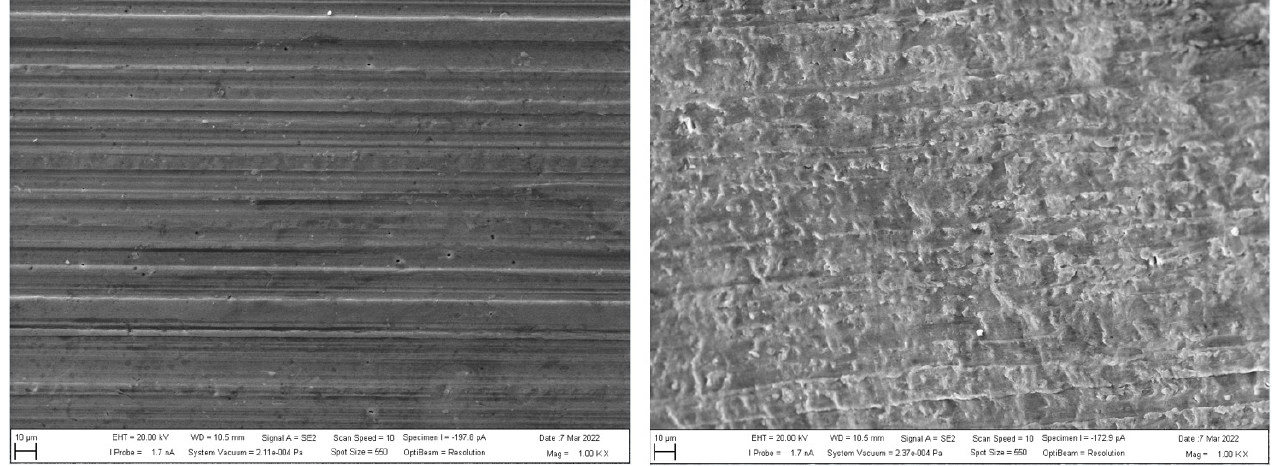
Figure 12. Comparison of original surface of Al sheet ( left ) and contact surface near joint ( right ), SEM.